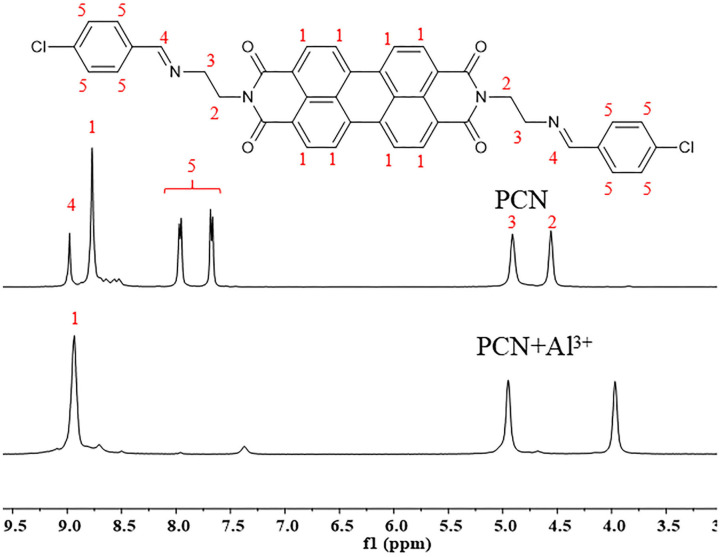
The 1H NMR spectra of PCN and the isolated product of PCN with Al3+.